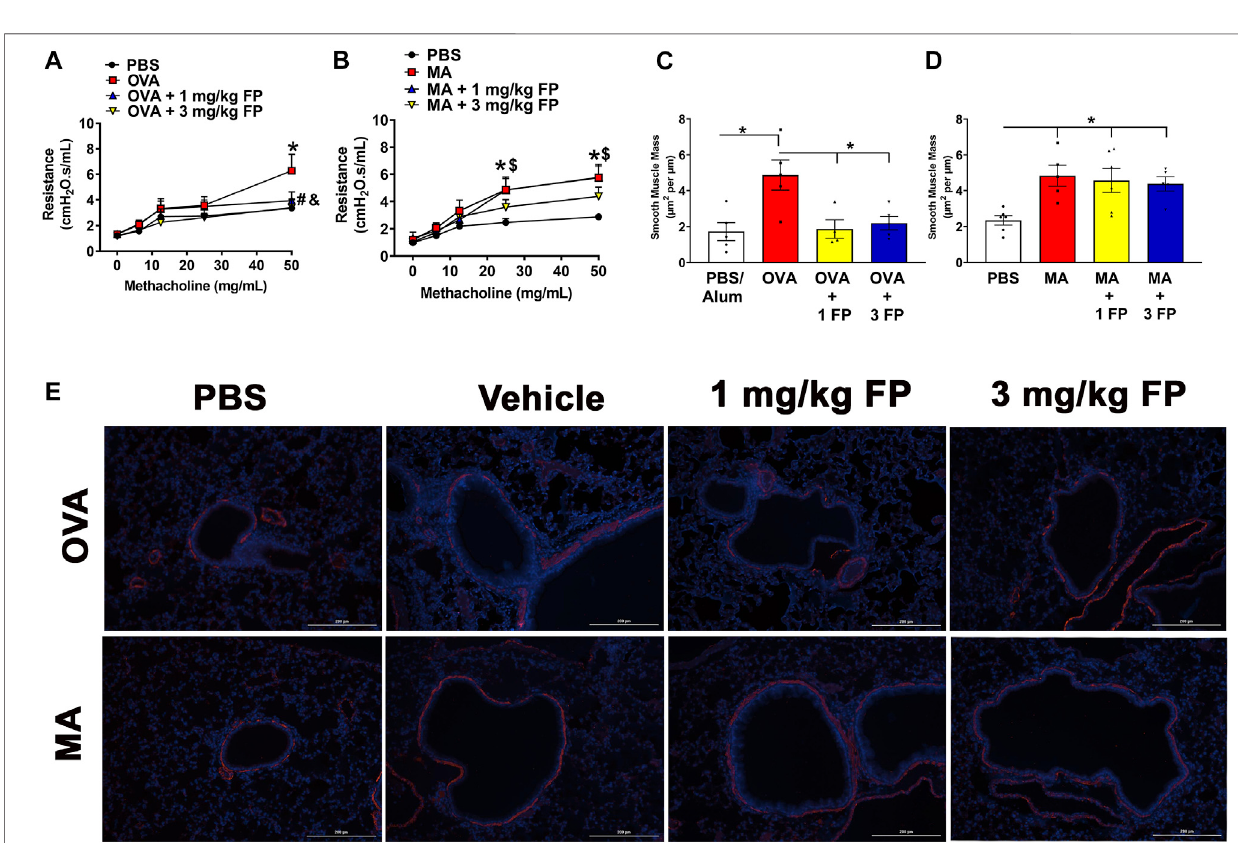
FIGURE 2 | Airway hyperresponsiveness (AHR) and smooth muscle mass are corticosteroid insensitive in MA mice. AHR is signi fi cantly increased in (A) OVA- and (B) MA-challenged mice. Treatment with 1 mg/kg and 3 mg/kg fl uticasone propionate (FP) signi fi cantly reduces AHR in OVA-challenged mice, but does not affect MA-challenged mice. (C) OVA- and (D) MA-challenged mice exhibited increased airway smooth muscle mass. Treatment with corticosteroids reduced ASM mass in OVA-challenged, but not MA-challenged mice. (E) Representative photomicrographs of left lung lobe sections stained with α -smooth muscle actin. Data are presented as ± SEM, n = 4 – 13 mice per group. p < 0.05. For AHR *, # indicates signi fi cant difference from PBS. $, and indicates signi fi cant difference from OVA- challenged mice. For ASM mass, * indicates signi fi cant difference between groups.